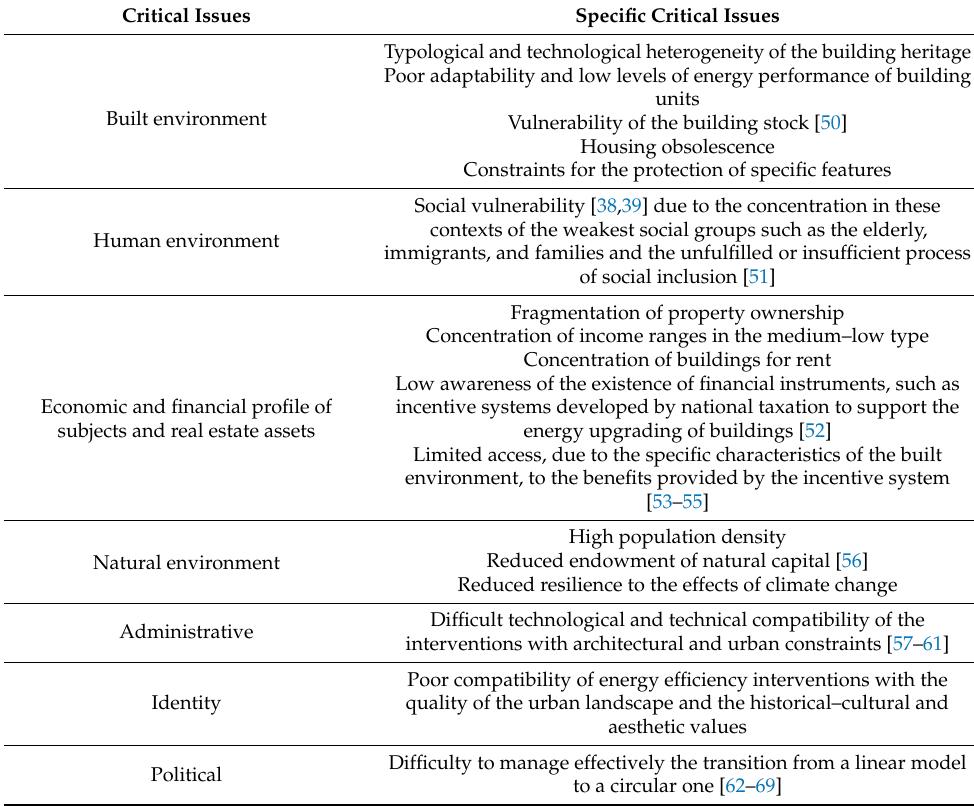
Table 1. Ecological transition critical issues in the historic